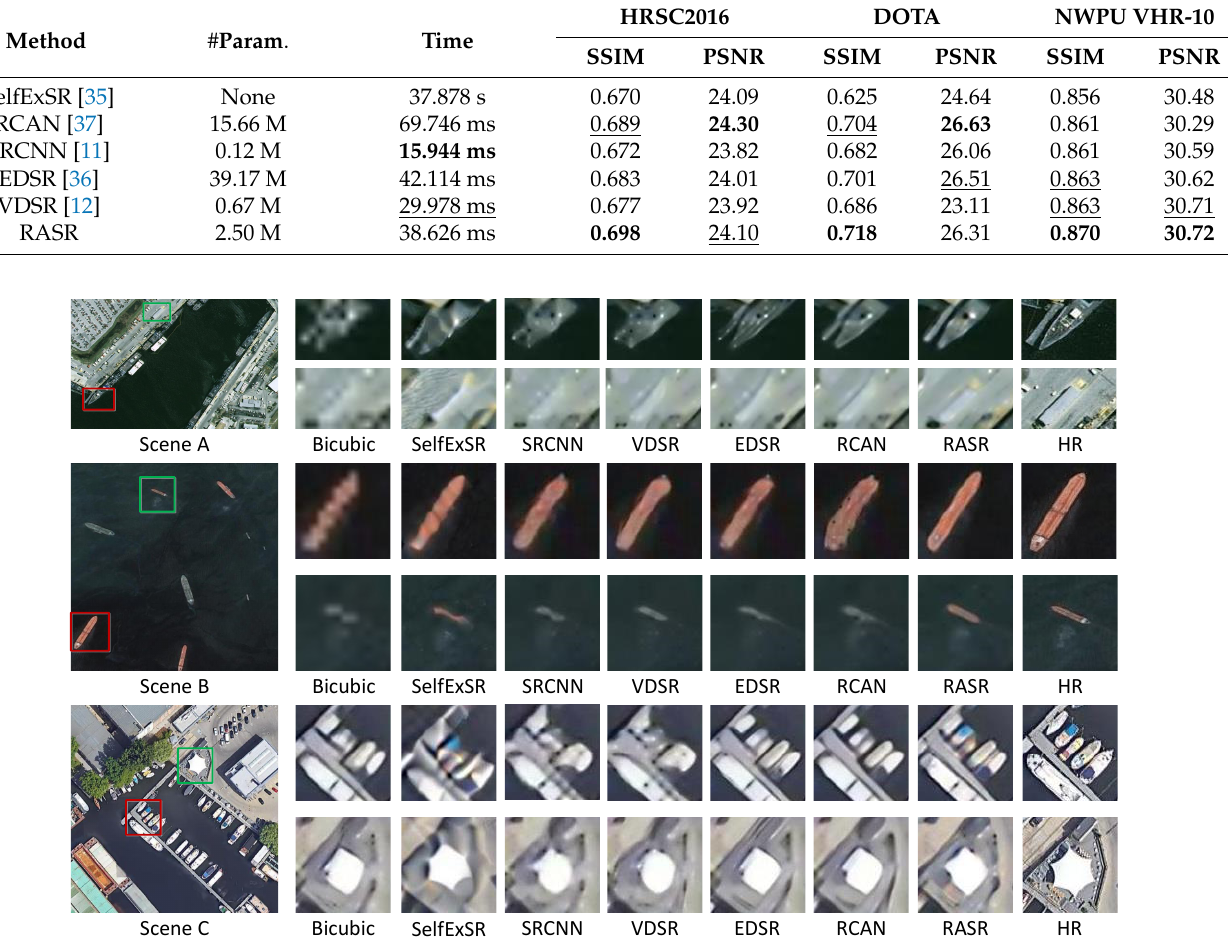
Figure 5. Visual results achieved by different SR